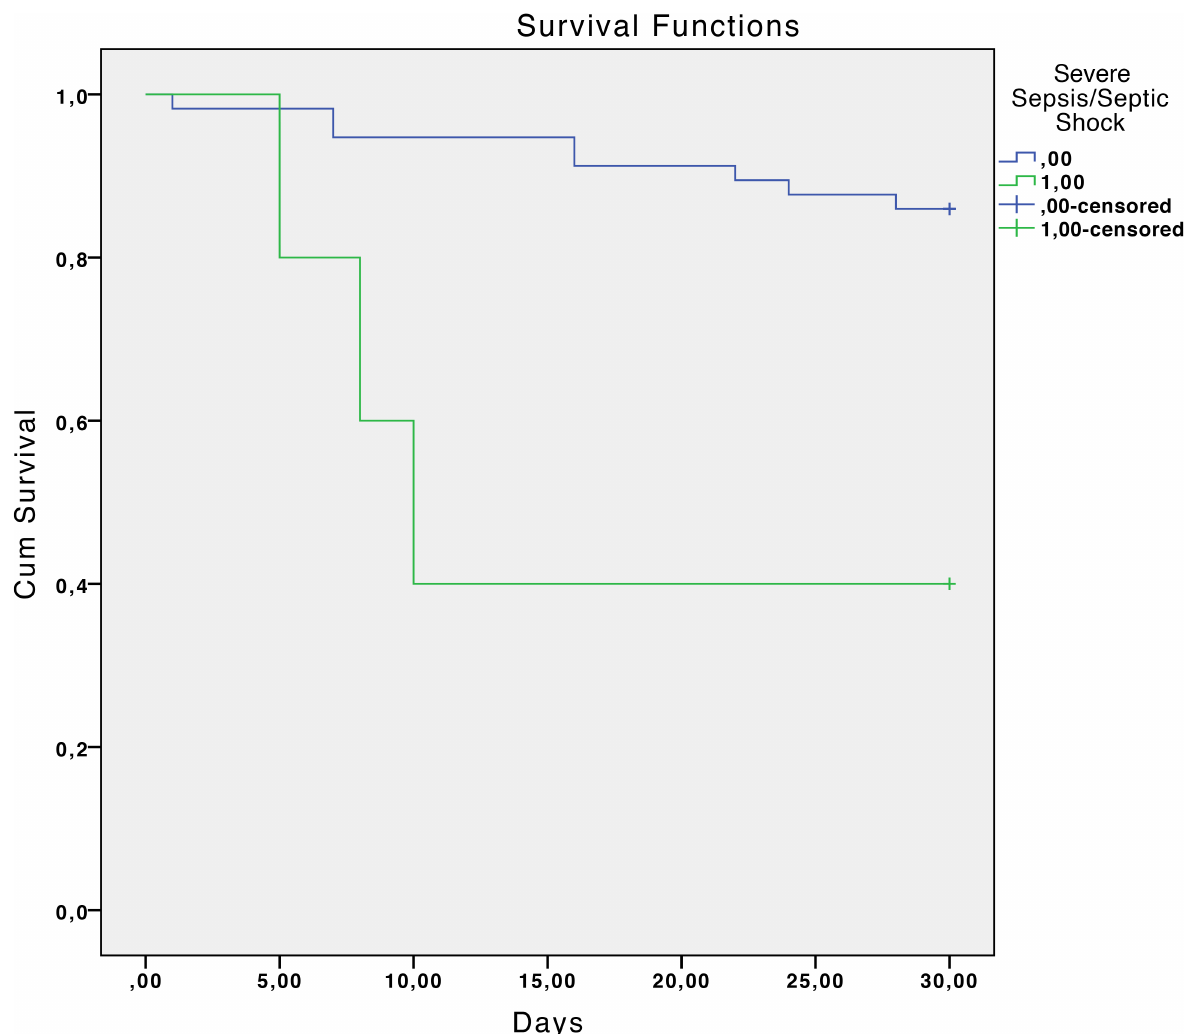
Fig 4. Kaplan-Meier 30-day survival curve according to severesepsis or shock. P < 0.01(log-ranktest).